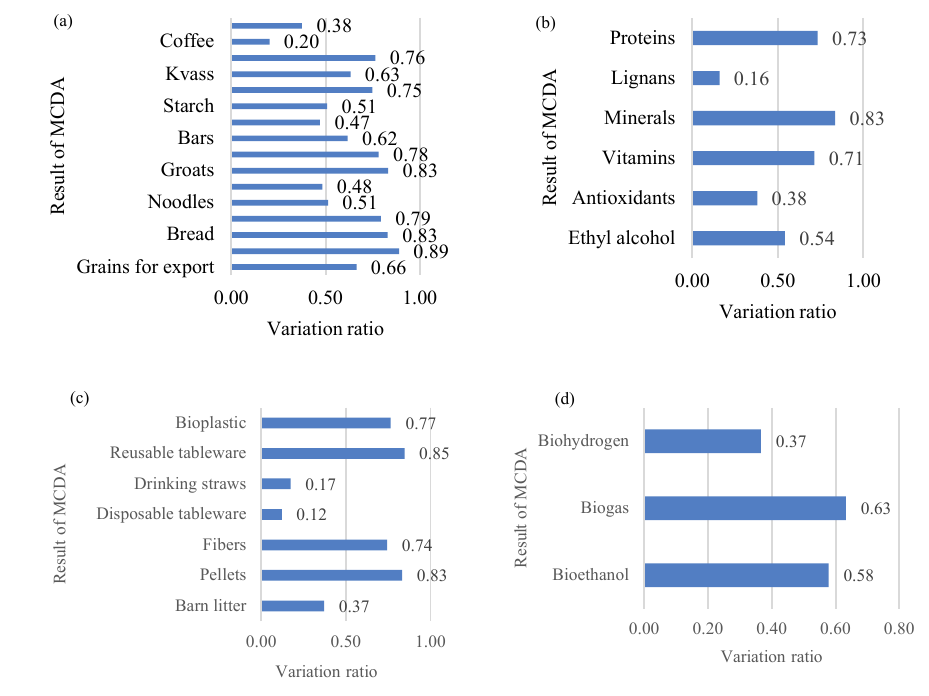
Fig. 6. MCDA TOPSIS analysis for the groups of: a) food; b) pharmaceutical; c) transport sector and d) straw products.